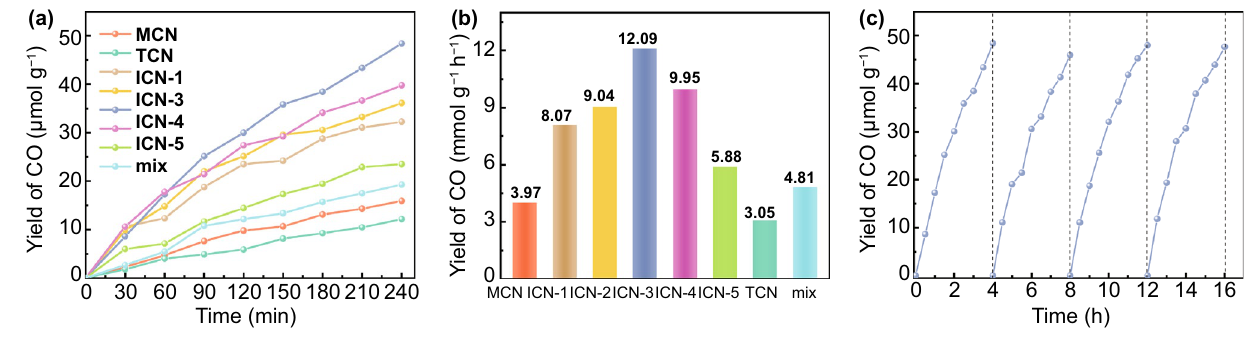
Fig. 5 a , b CO production rates from photocatalytic CRR under irradiation. c Photocatalytic stability test of ICN-3 for 240 min in each